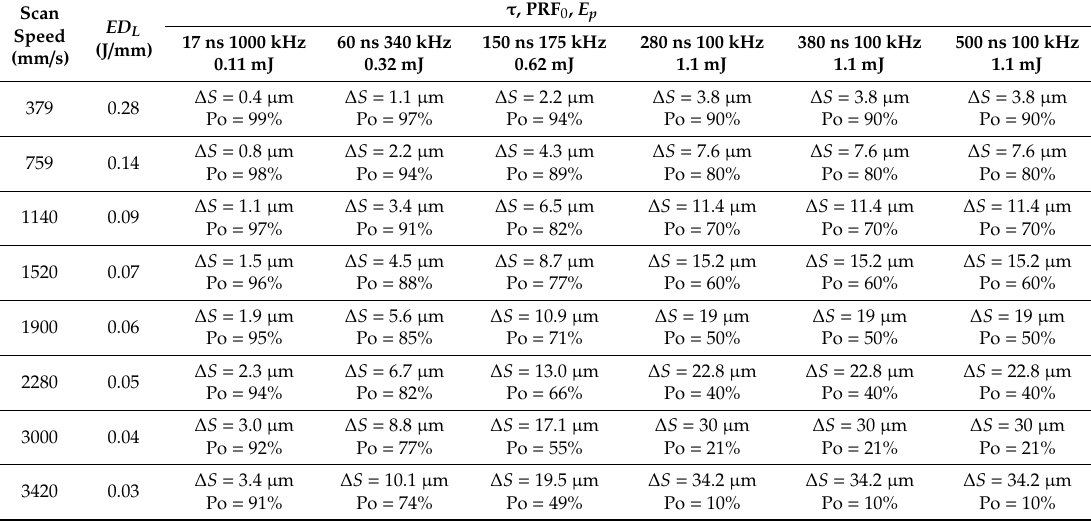
Figure 3. ( a ) Surface height map of lines machined with 280 ns pulses at different line energy doses ( ED L ). ( b – d ) Extracted 3D profiles of the highlighted region: ( b ) full profile, ( c ) extracted groove profile (material removed), and ( d ) extracted burr profile (redeposited material) [ µ m]. Table 1. List of parameters for single-line machining study. The pulse to pulse distance ( ∆ S ) and the pulse overlap factor (Po), which is the fraction of the laser spot diameter that overlaps with the previous pulse on the surface of the material, at given energy doses ( ED L ) for different pulse durations ( τ ) are provided. All pulse repetition frequencies (PRF) indicated correspond to the PRF 0 condition.